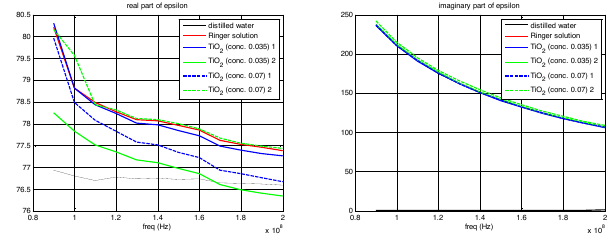
Figure 7: Variation of the real ( left ) and imaginary ( right ) part of the complex dielectric constant in the range [60 , 200] MHz for different